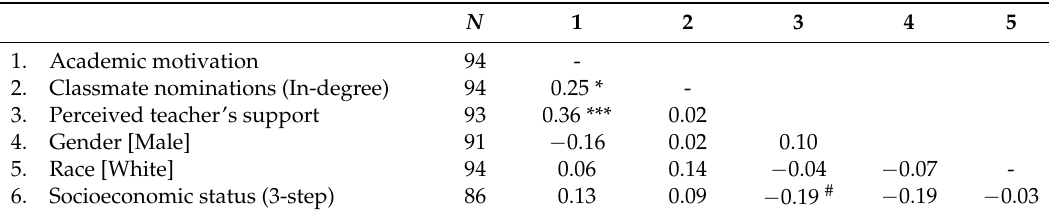
Table 2. Pearson’s correlation coefficients of the tested variables ( # p < 0.10, * p < 0.05, *** p < 0.001). Race/ethnicity was recoded as White vs. non-White. Socioeconomic status measured students’ perceived family social class. It is a 3-step measure that includes lower class/poor, middle-class/sufficient, and upper